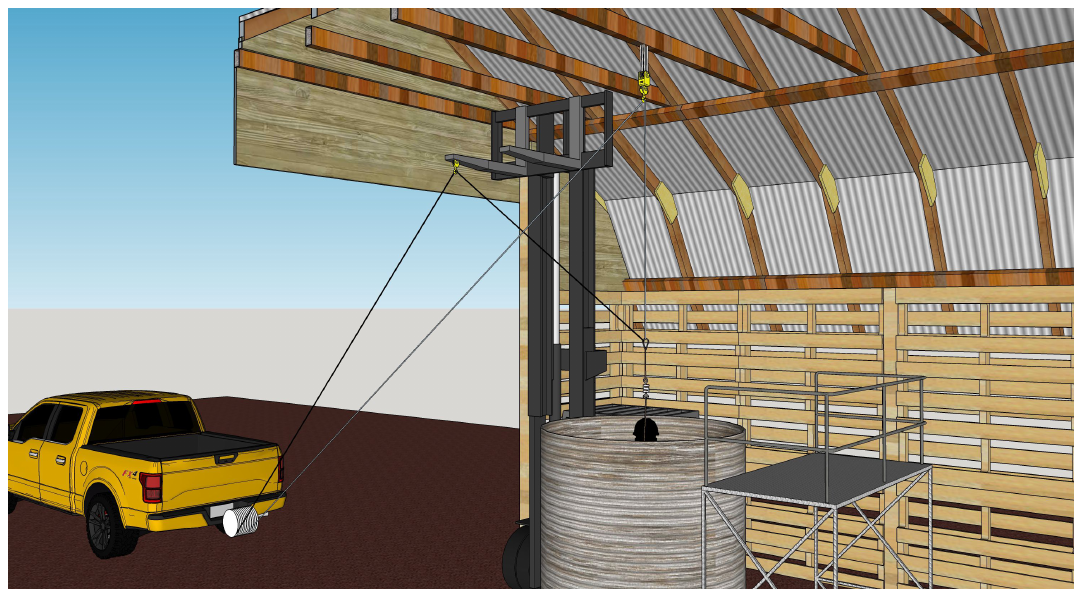
Figure 1. Experimental setup showing location of mechanical winch, forklift (angle anchor point), vertical anchor point, and observation deck. Grain bin was located on top of grain pit and below grain loading output (not shown).